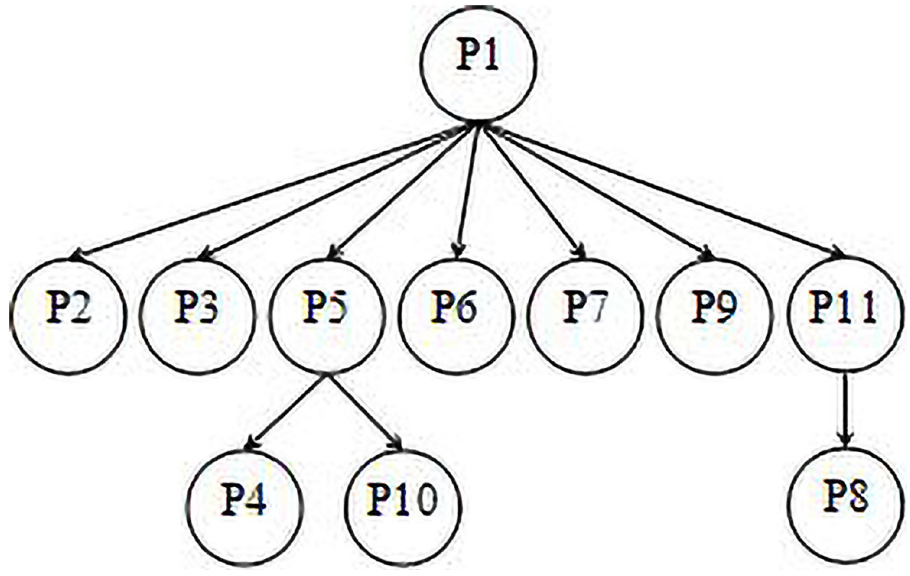
Fig 2. Index structure of the toy